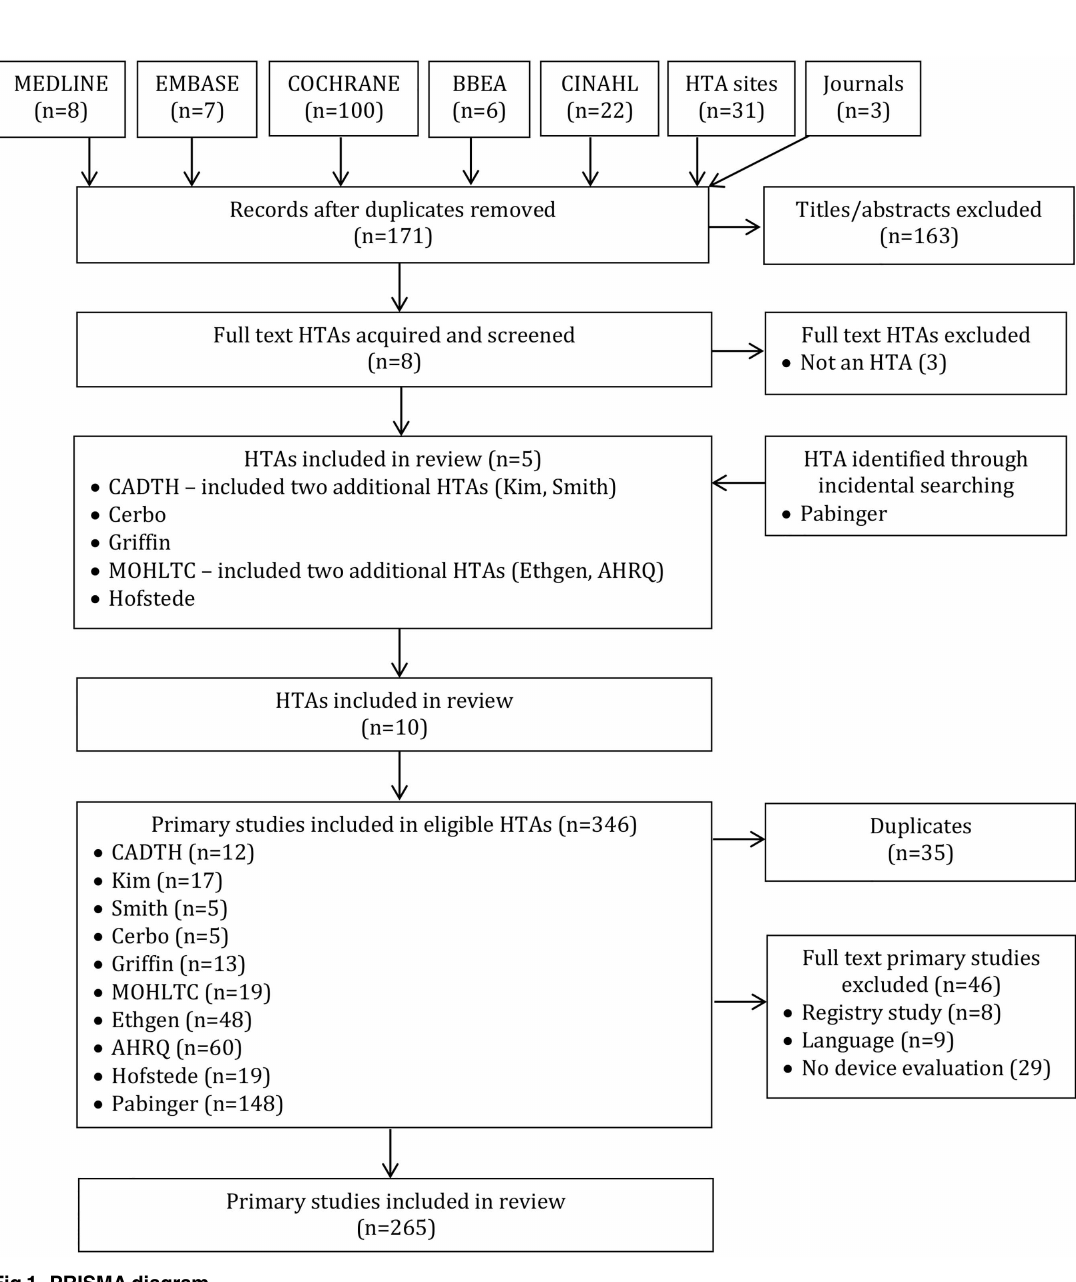
12.0 to 3,998.0; UKA median 88.0, range 28.0 to 447.0; both median 206.0, range 20.0 to 750.0); and 6.7% of patients assessed in RCTs (TKA median 92.0, range 20.0 to 390.0; UKA median 55.0, range 40.0 to 92.0; both median 39.0, range 22.0 to 56.0). Follow-up period Patients were followed for 2 years or less in a high proportion of studies for both UKA (SC 29.8%, CC 16.7%, RCT 25.0%) and TKA (25.0%, 31.4%, 48.6%) (Table 4)